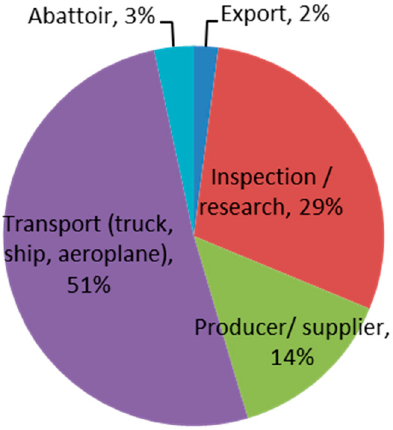
Figure 1. Breakdown of the background of live export industry (LEI) workers who responded to this survey.